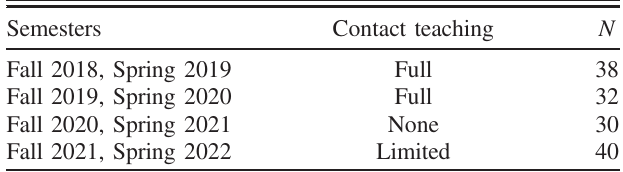
TABLE I. Number of responses each academic